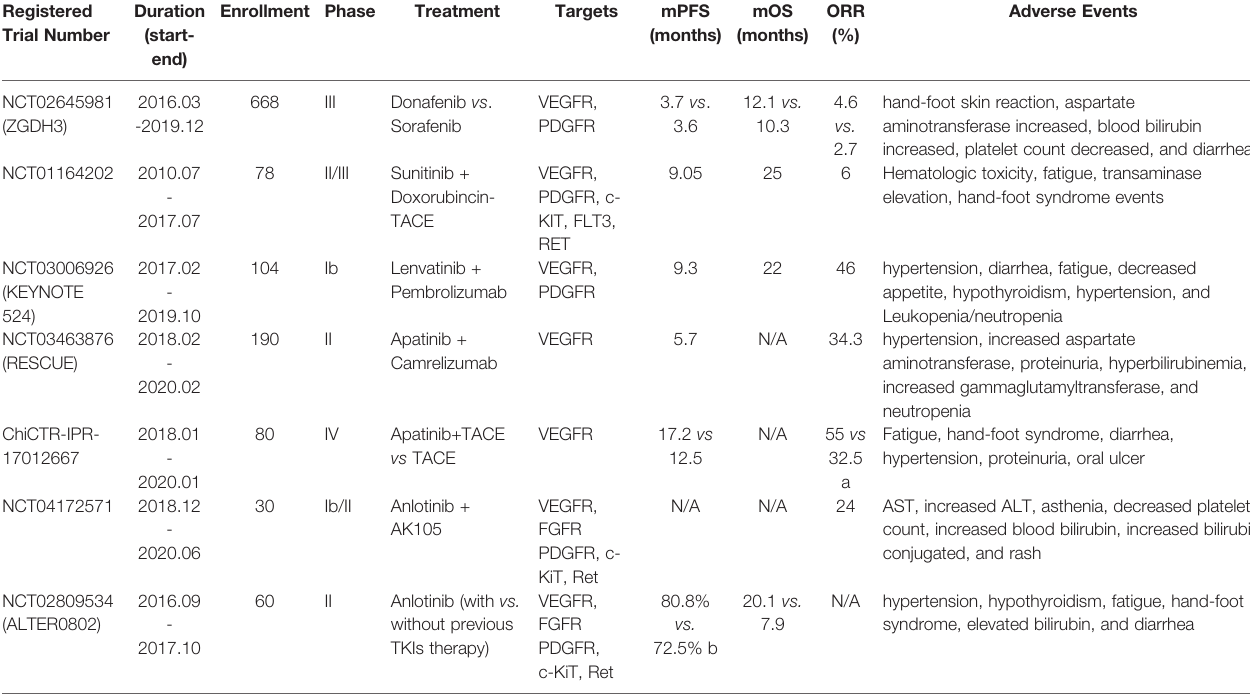
TABLE 2 | Representative clinical trials of tyrosine kinase inhibitors in hepatocellular carcinoma treatment. Registered Duration Trial Number